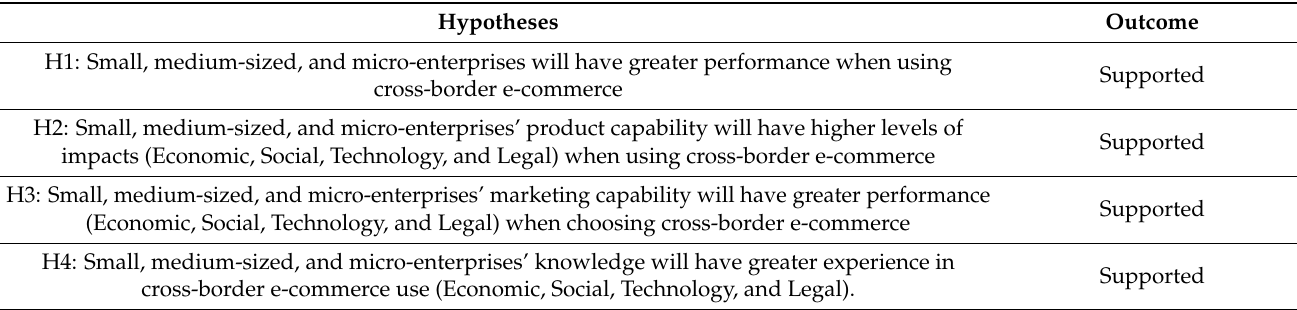
Table 5. Hypotheses